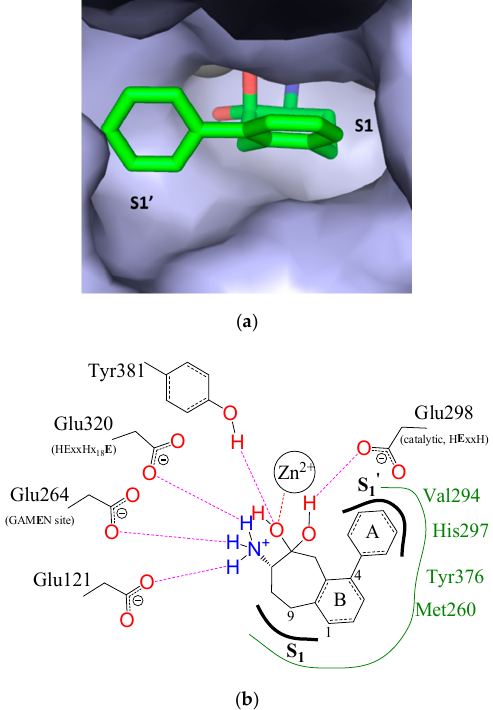
Figure 2. Interactions of aminobenzosuberone derivative 21c with Ec PepN. ( a ) Surface representation of compound 21c in the active site of Ec PepN (PDB 5MFS). The binding pocket is shown in light-blue surface representation and the zinc ion is represented by a grey sphere (prepared using PyMOL Molecular Graphics System). ( b ) Schematic representation of compound 21c binding mode in the active site of Ec PepN. Hydrogen bond and metal interactions are shown with dotted purple and red lines, respectively. Green lines represent the hydrophobic residues located in the active site